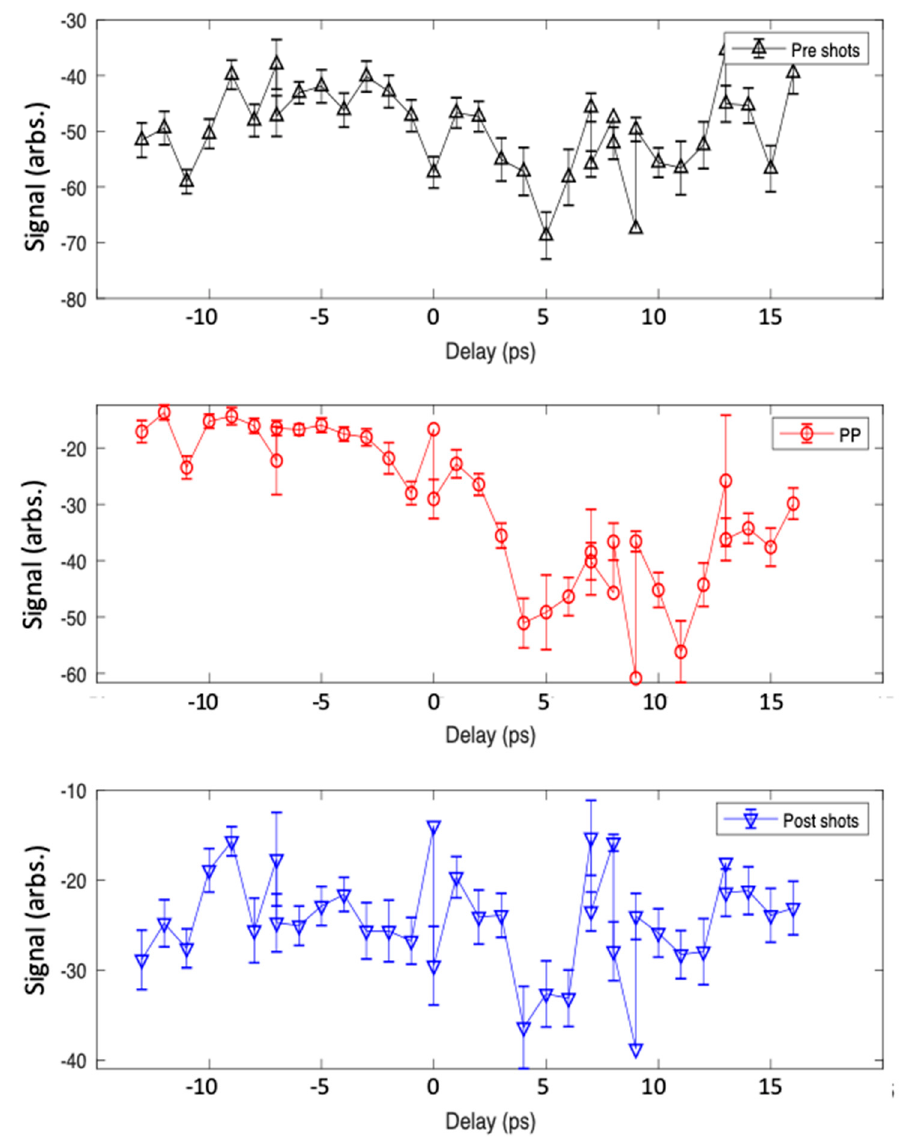
Figure 4. The reflectivity curves from a representative sample for 41.83 nm horizontally polarized light. The pre-shots (black triangles), pump-probe (red circles) and post-shots (blue triangles) corresponding to steps (i) (ii) and (iii), respectively. Only the pump-probe shows a large change in reflectivity on the timescale studied here.